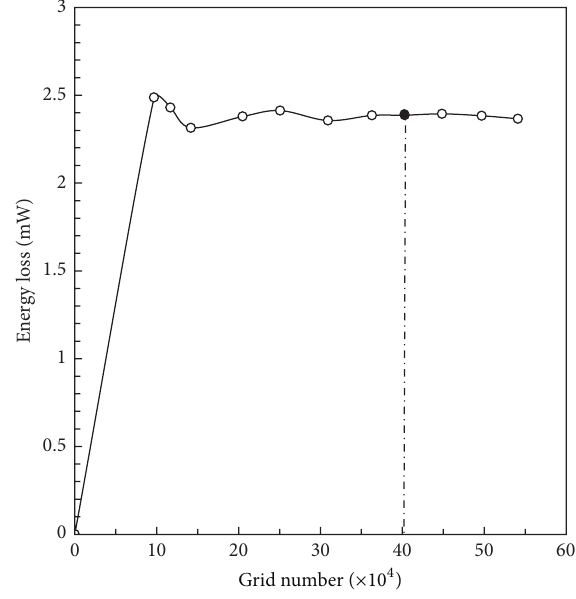
Figure 5: Results of grid independent